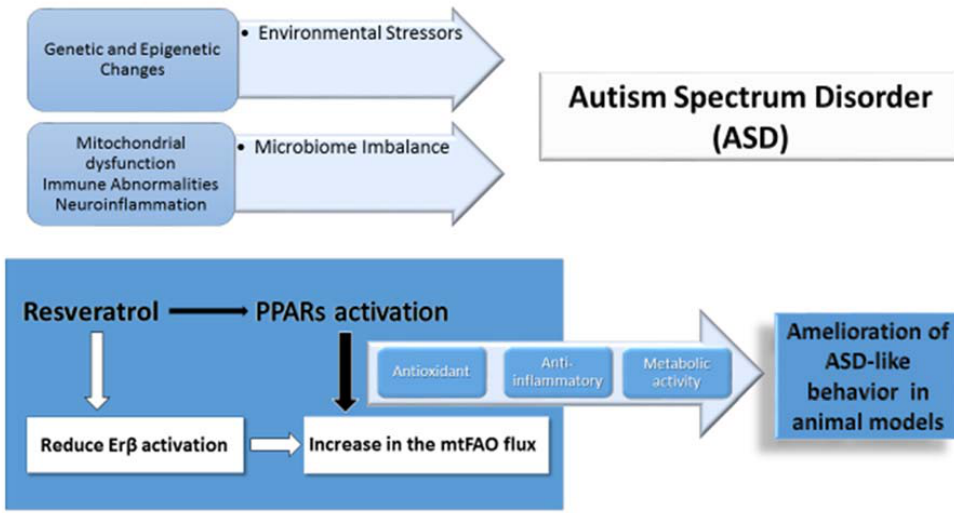
Figure 1. Pathogenetic mechanisms of autism spectrum disorder (ASD) and related resveratrol (RSV) actions with potential therapeutic effects proven in ASD animal models.